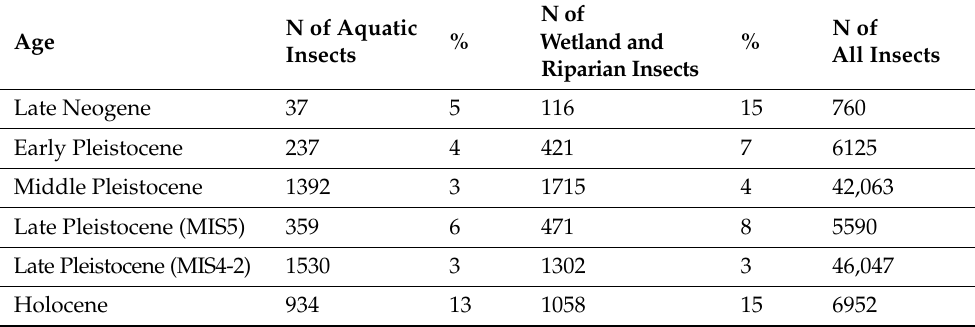
Table 3. Occurrence of water indicators and their percentage of assemblages in different stratigraphic units. Age